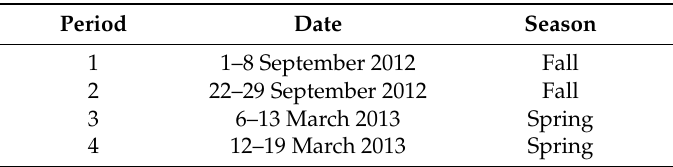
Table 3. Selected time periods to assess the O 3 production sensitivity using the California/Carnegie Institute of Technology (CIT) photochemical box